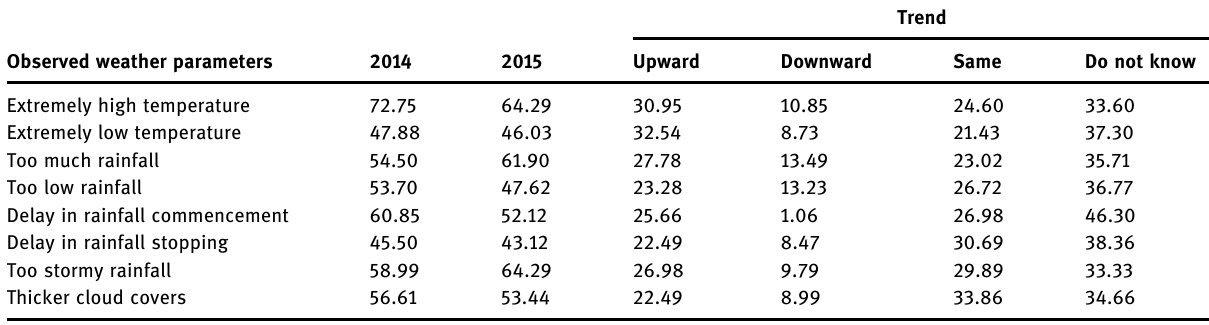
Table 3: Perceived trends of changes in some weather parameters